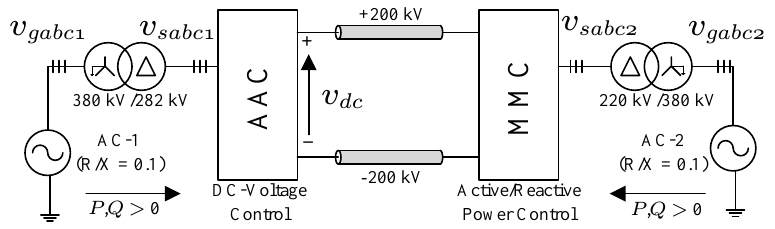
Figure 3. MMC and AAC-based hybrid VSC-HVDC